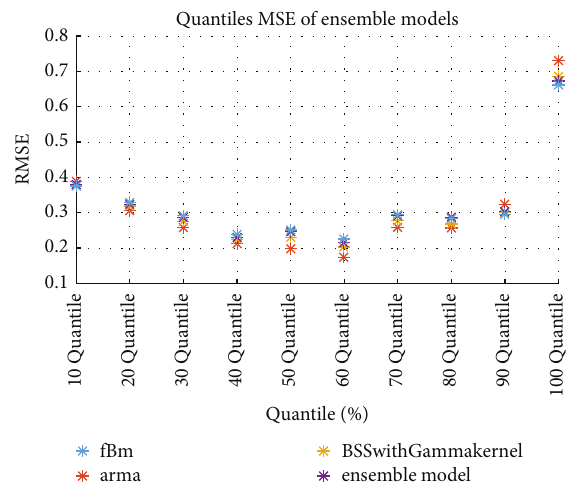
Figure 9: Quantile error of realized volatility of three volatility prediction models and their integrated